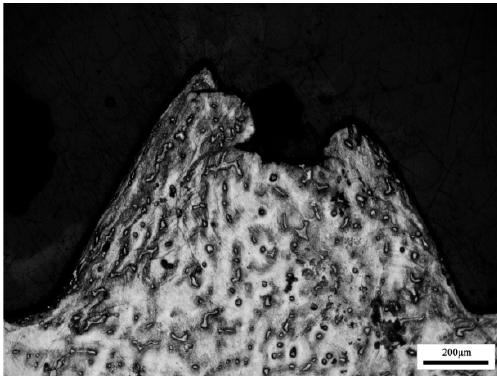
Figure 7. Optical image of the thread profile.